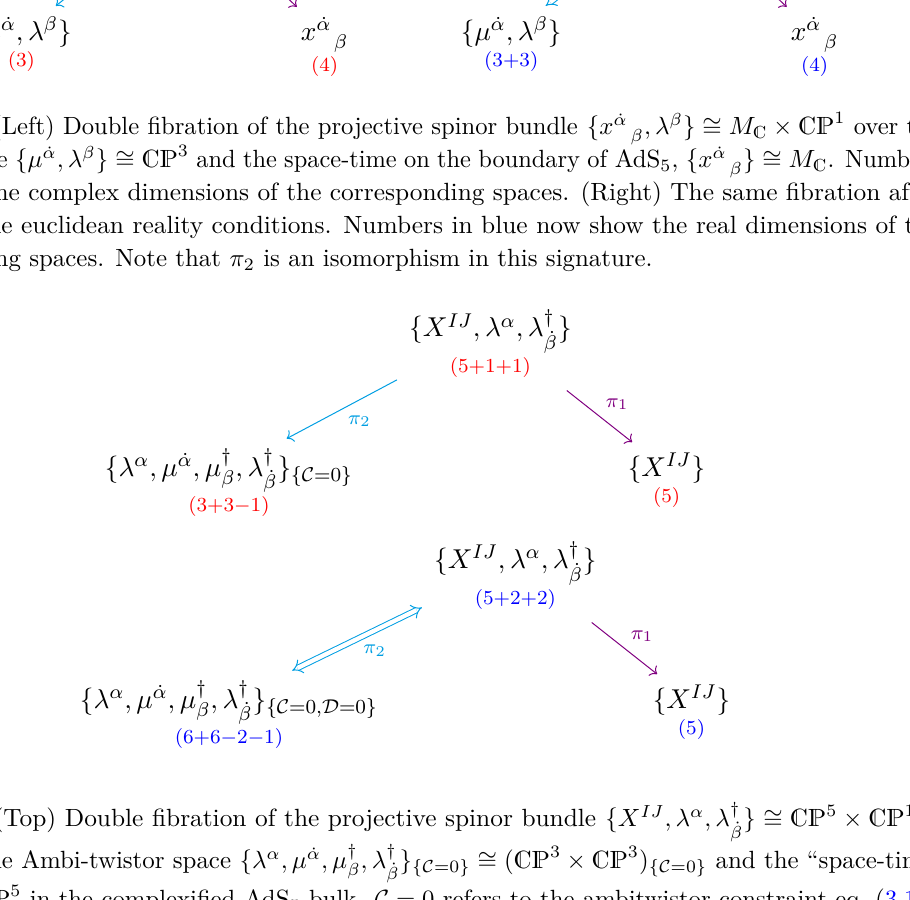
Figure 5 . (Top) Double fibration of the projective spinor bundle { X IJ , λ α , λ † CP 1 over the Ambi-twistor space { λ α , µ ˙ α , µ † { X IJ } ∼ = CP 5 in the complexified AdS 5 bulk. C = 0 refers to the ambitwistor constraint eq. (3.13). Numbers in red are the complex dimensions of the corresponding spaces. (Bottom) The same fibration after imposing the euclidean reality conditions which leads to the additional constraint D = 0 — see eq. (3.33). Numbers in blue are the real dimensions of the corresponding spaces. Note that π 2 is an isomorphism in this